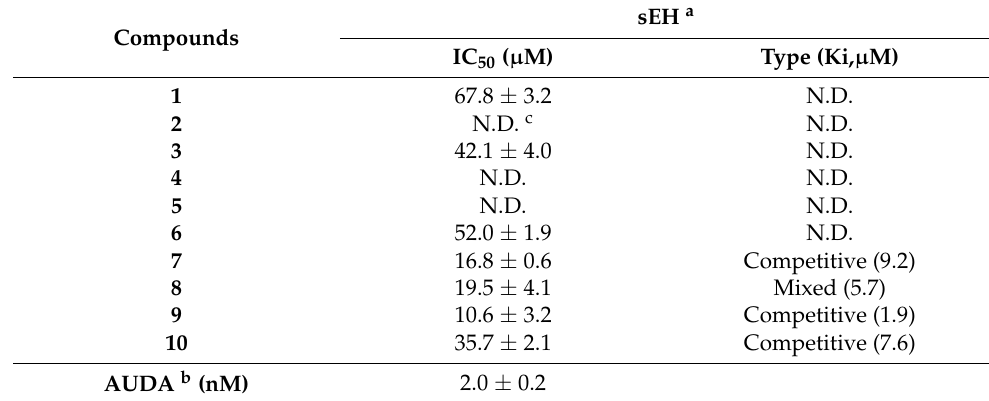
Table 1. Inhibitory activity of compounds 1 – 10 on soluble epoxide hydrolase (sEH). sEH a Compounds IC 50 ( µ M) Type (Ki, µ M) 1 67.8 ± 3.2